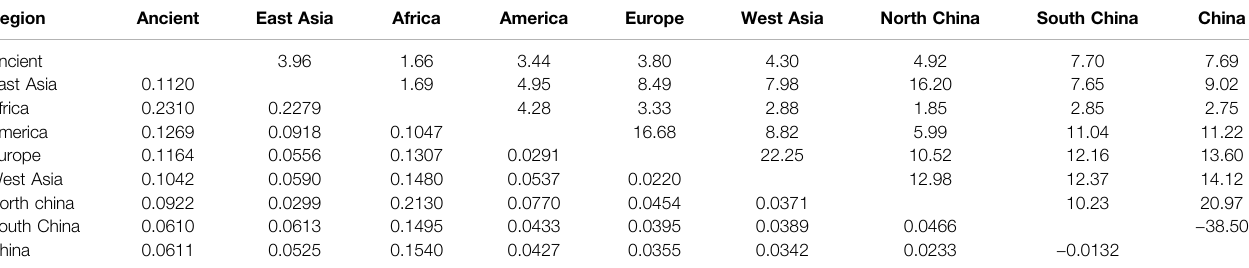
TABLE 3 | Population pairwise Fst values (the below diagonal) and gene fl ow (Nm, the above diagonal) among T haplogroup of dataset B and ancient samples. Region Ancient